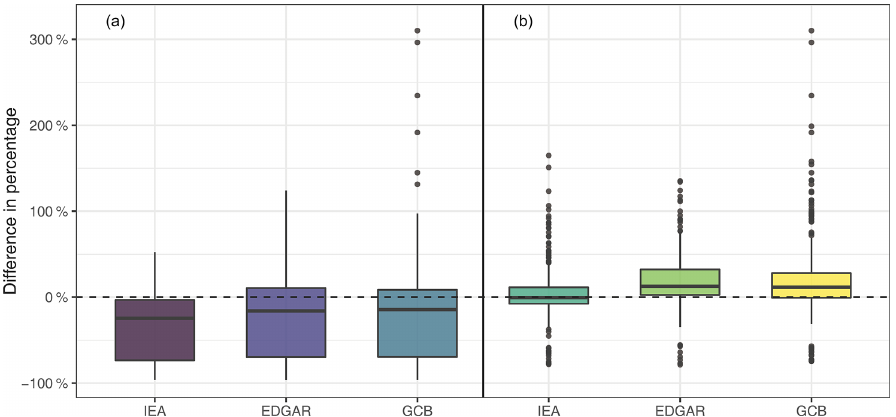
Figure 6. Disparities between the published data of three institutes (IEA, EDGAR, and GCB) and the CEADs inventory with (a) and without (b) biomass emissions. The boxplots show the minimum, the first quartile, the median, the third quartile, and the maximum of the differences across the nation–year emission data among the institutes. The percentages are the relative difference between the three institutes and CEADs. For instance, (a) shows that emission data from IEA, EDGAR, and GCB are generally lower than those in the CEADs inventory, while (b) shows that the data from these three institutes are close to the CEADs inventory when biomass emissions are excluded from